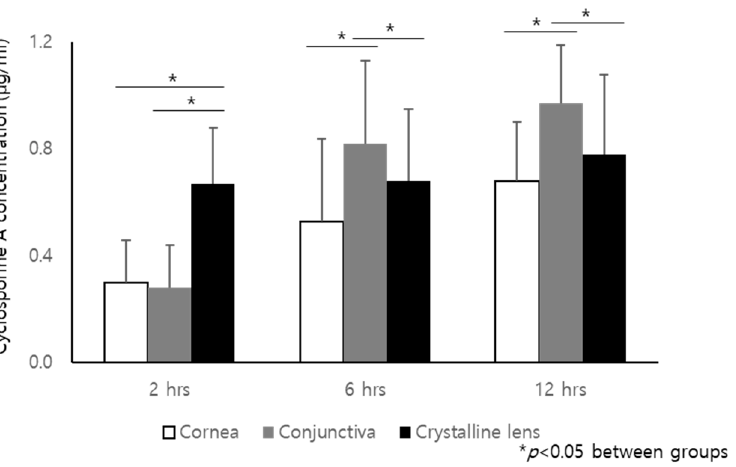
Figure 2. The concentration of cyclosporine A (CsA) in the cornea, conjunctiva, and crystalline lens of the rabbits at 2, 6, and 12 h after applying the CsA-loaded pH-responsive contact lens. All data are presented as mean and